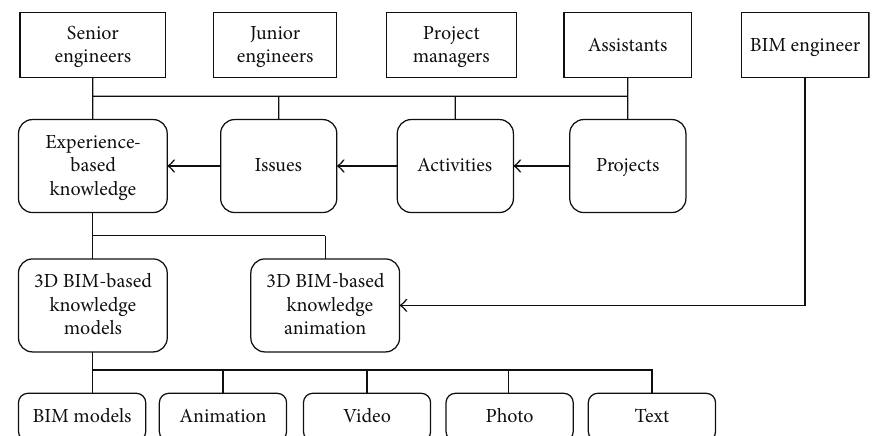
Figure 2: The concept and framework of the BIM-based knowledge